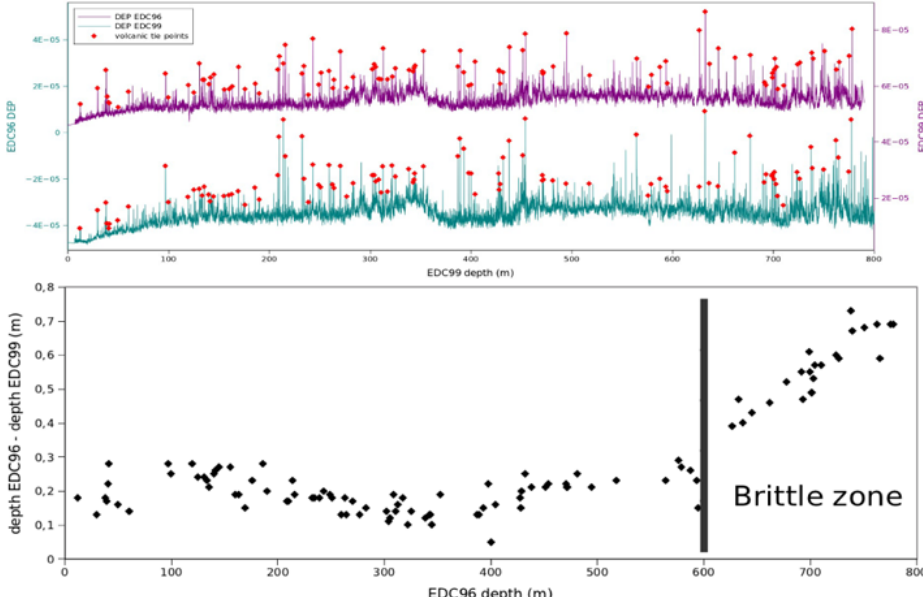
Fig. 4. Volcanic synchronisation of the EDC96 and EDC99 ice cores using the DEP records. (A) DEP records and volcanic tie points. (B) Resulting depth offset between EDC96 and EDC99. The vertical bar marks the start of the brittle zone.